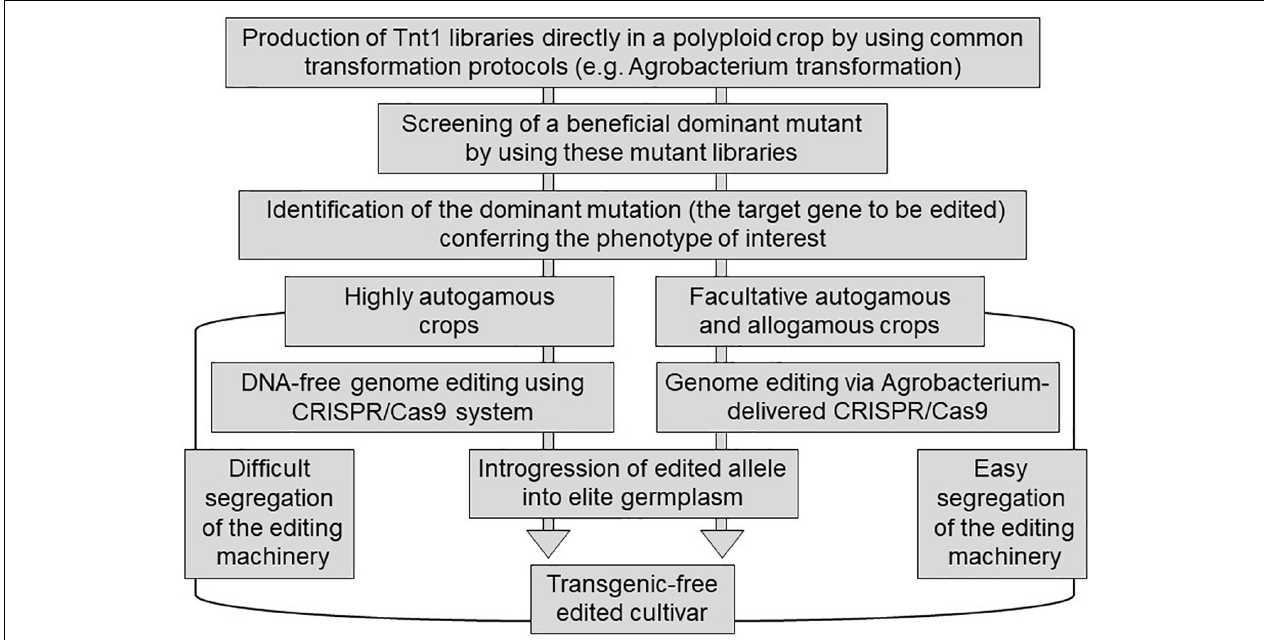
FIGURE 2 | Schematic representation of the possible combination of Tnt1 element and the CRISPR/Cas9 system to rapidly improve polyploidy crops. This picture is explained in the